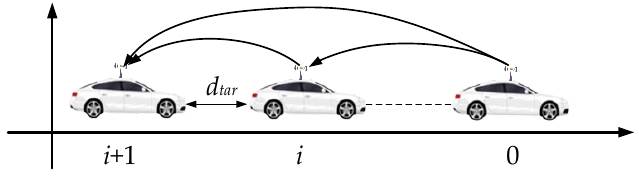
Figure 4. The spacing policy for ICVs.